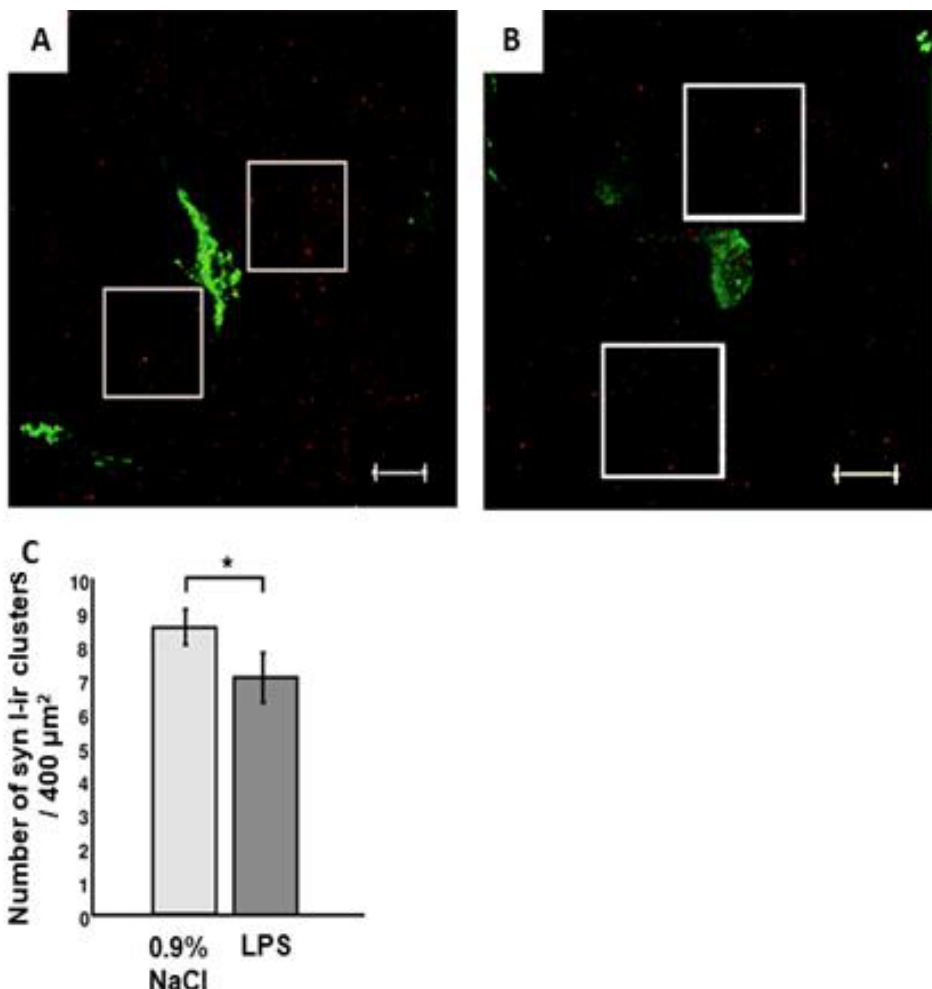
Figure 1. Synapsin-1-immunoreactive (syn 1-ir) clusters in areas adjacent to the GnRH neurons. Representative photomicrographs of male rat neurons on PND80 exposed on ED12 to ( A ) 0.9% NaCl (control) and ( B ) lipopolysaccharide (LPS, 50 μg/kg) stained with anti-GnRH (green) and anti-synapsin-1 (red) antibodies (n = 10 animals per group). Scale bar = 10 μm. ( C ) Average number of syn 1-ir clusters from two 400 μm 2 areas (white box) placed at both sides of each neuron. M ± SEM, * p < 0.05 between groups. Approximately 10 visible GnRH-immunoreactive neurons on each of the 8–10 sections from each animal were analyzed.